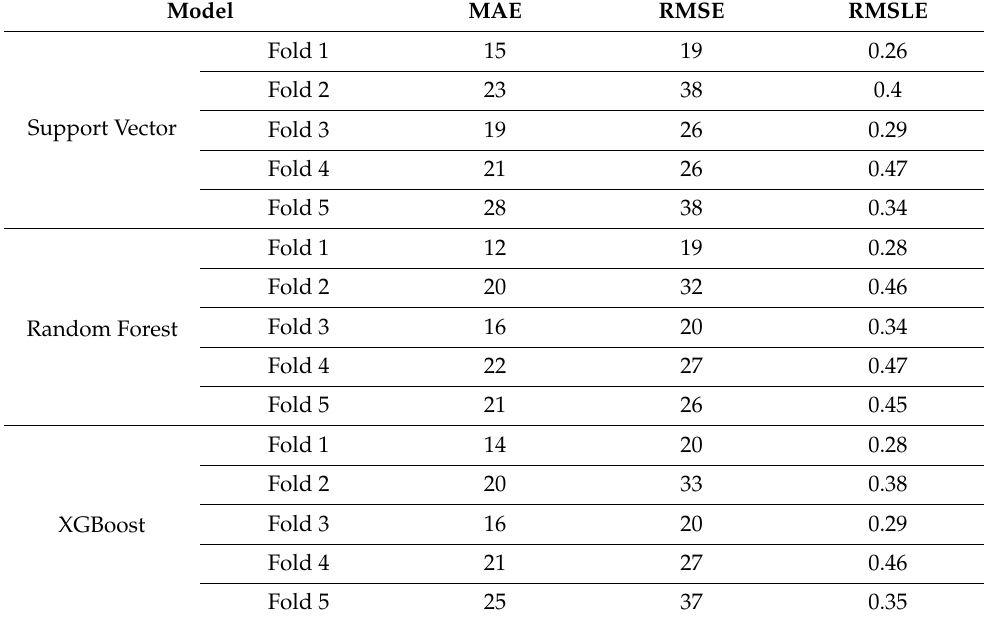
Table 2. Comparison of model performance